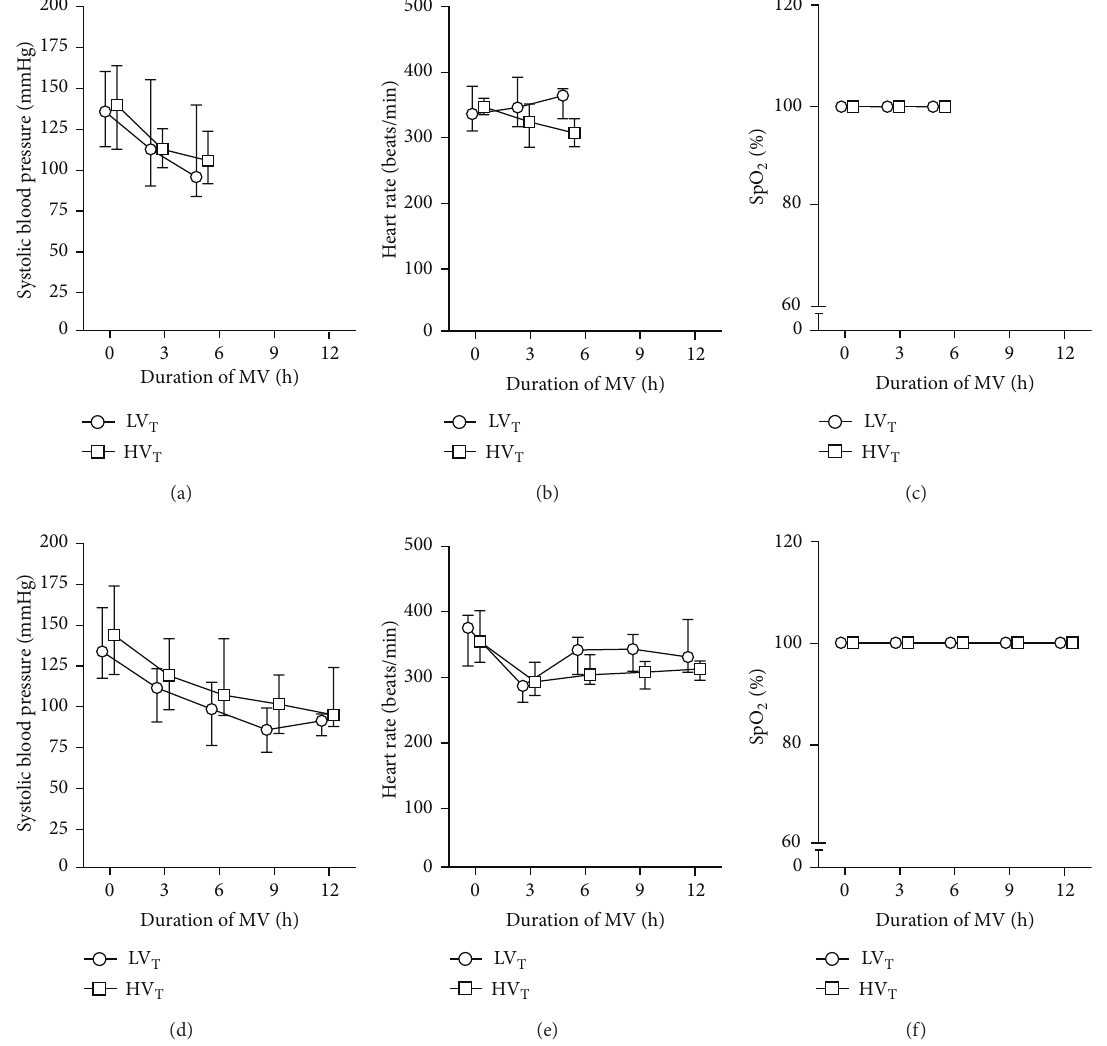
Figure 1: Hemodynamic parameters. Systolic blood pressures, heart rates, and peripheral oxygen saturation (SpO 2 ) remained stable throughout 5 hours ((a)–(c)) and 12 hours ((d)–(f)) of mechanical ventilation (MV). Data are presented as median (IQR) of 12–15 ((a)-(b), (d)-(e)), or 3–6 ((c), (f)) mice per group (circle = LV T ; square = HV T ). LV T , HV T = LV T /PEEP or HV T /ZEEP ventilator